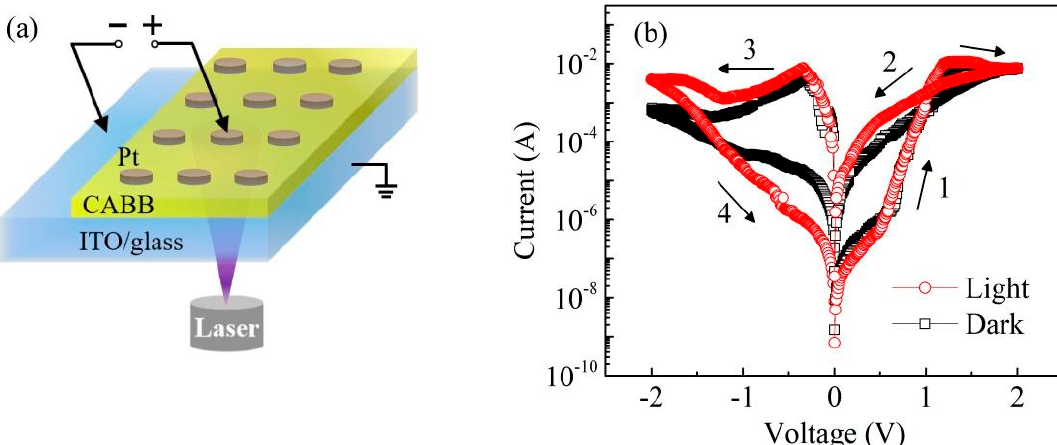
Figure 2. ( a ) Schematic of the Pt/CABB/ITO/glass devices used for RS performance measurements. ( b ) The semi-logarithmic plot of I – V curves of the CABB-based device in the dark and under light illumination (445 nm, 4.67 mW/cm 2 ) with a sweep voltage of 2 V. Arrows and numbers represent the sweeping direction and sequence of bias voltages, respectively.